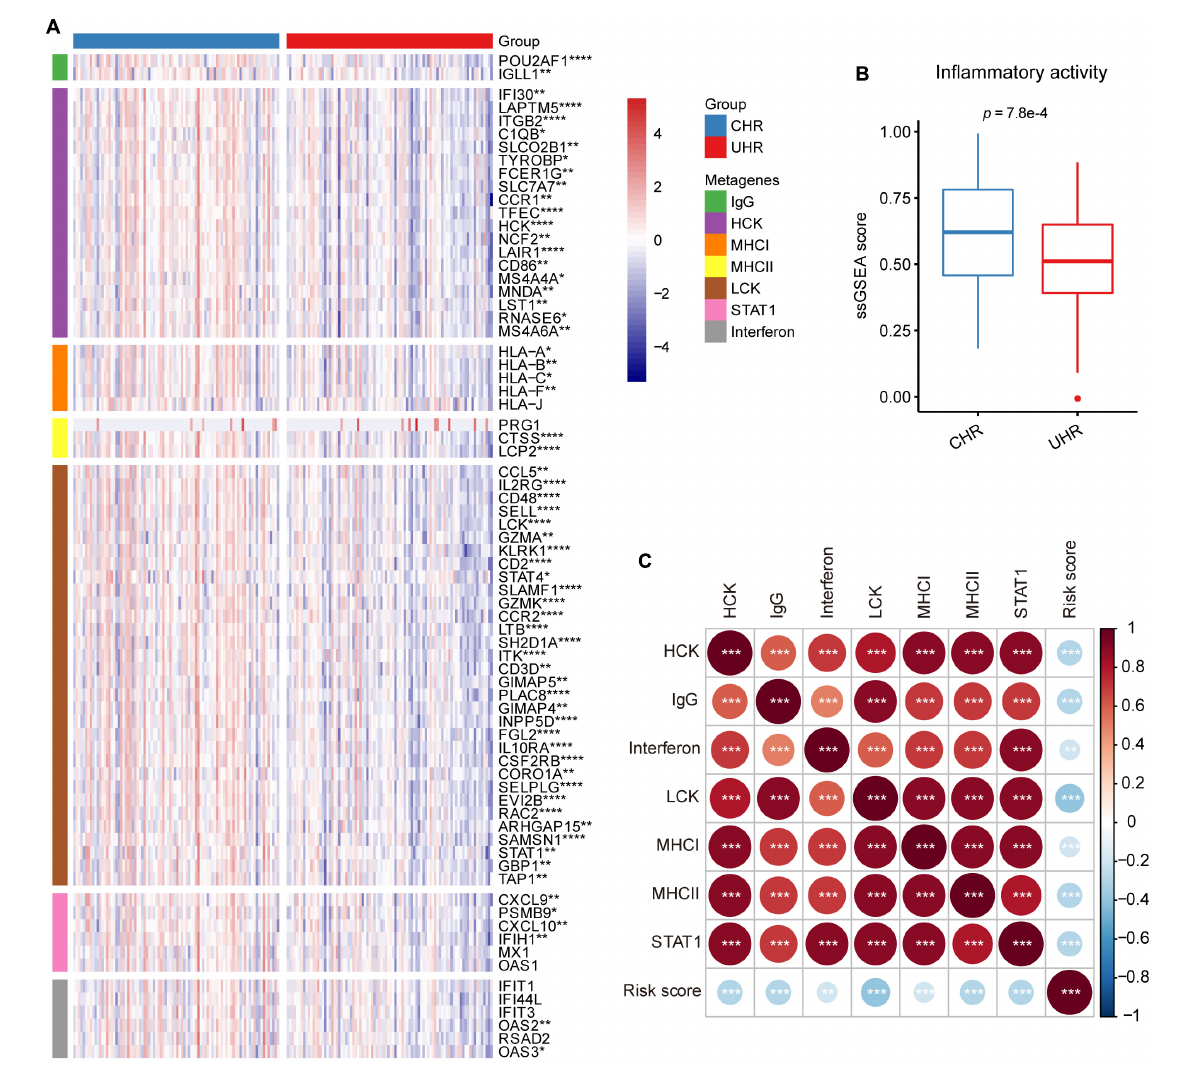
FIGURE7 Relationship between MMGS and inflammatory metagenes in the SEQC cohort. (A) Heatmap showing the expression characteristics of seven clusters of metagenes. (B) The ssGSEA score of inflammatory activity in MMGS risk groups. (C) The correlation between MMGS risk scores